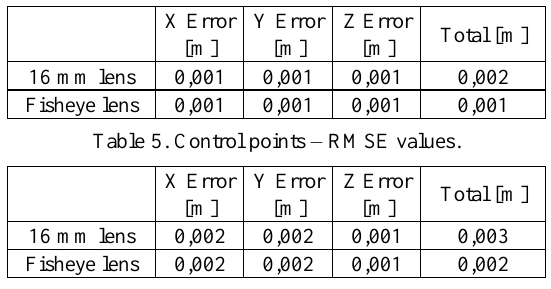
Table 6. Check points – RMSE values.